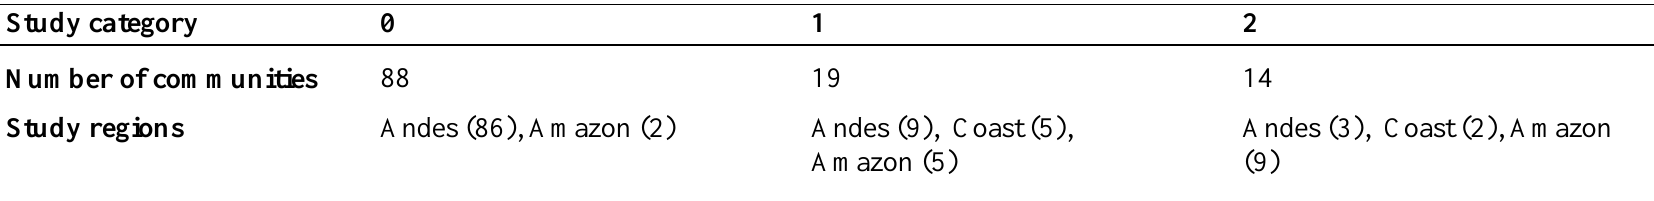
Table A1.1. Overview of studies and their characteristics Study